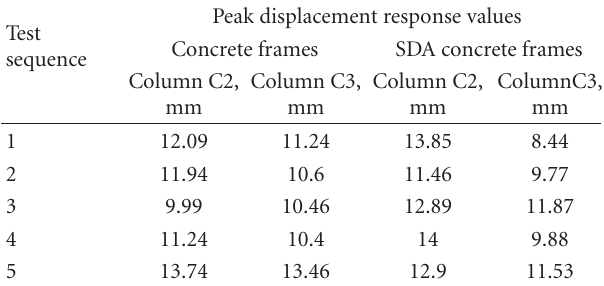
Table 10: Peak displacement response values of concrete and SDA concrete frames.